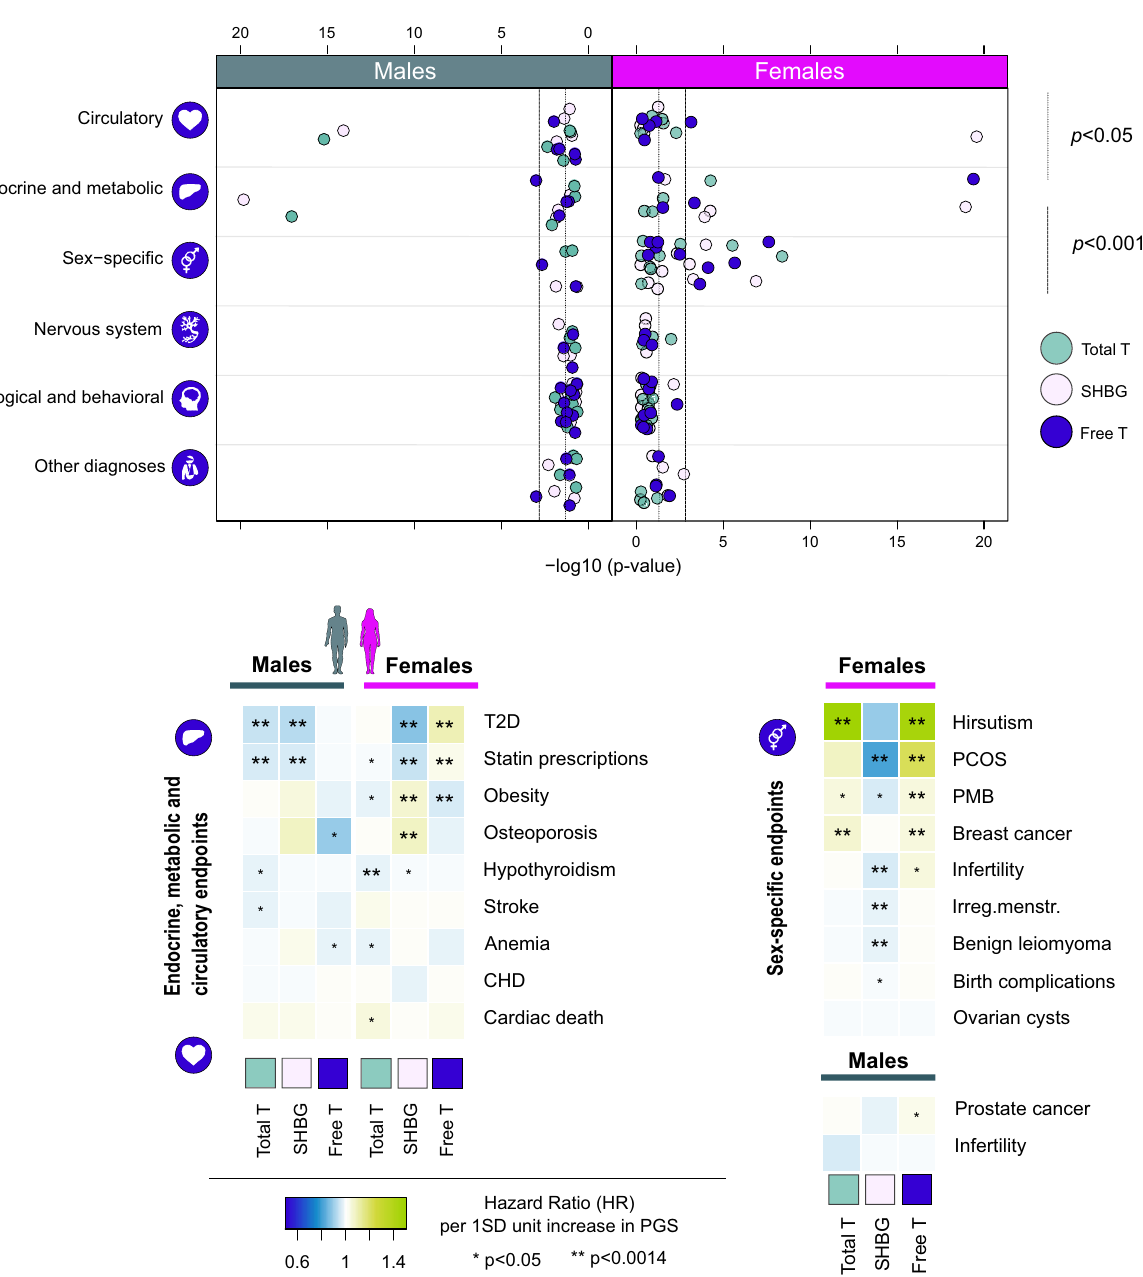
Fig. 2 Results from the PGS associations with disease endpoints in the FinnGen. a Illustrates the distribution of association p -values by disease category for each biomarker PGS separately for both sexes. For clarity p values capped at 1e-20. Dark green symbol = males, pink = females. Green circles = total testosterone, white lilac = SHBG, blue = free testosterone. b Shows hazard ratios per one SD increase in PGS for 20 traits from endocrine, metabolic, circulatory and sex-speci fi c categories. Yellow shades = increased risk for endpoint, blue shades = decreased risk for endpoint. The data is based on 94,478 men and 122,986 women from FinnGen R5. Case and control numbers for each endpoint are available from Supplementary Data 7. * p < 0.05, ** p < 0.0014, corresponding to Bonferroni correction for 36 independent traits. PCOS polycystic ovary syndrome, PMB post-menopausal bleeding, CHD coronary heart